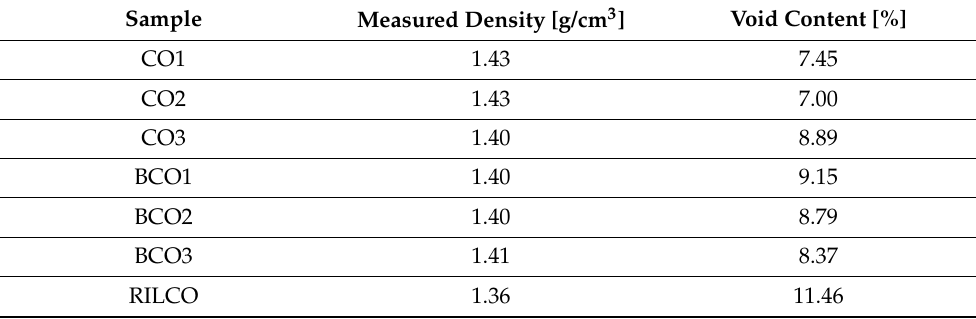
Table 4. Overview of the density of composites and void content.